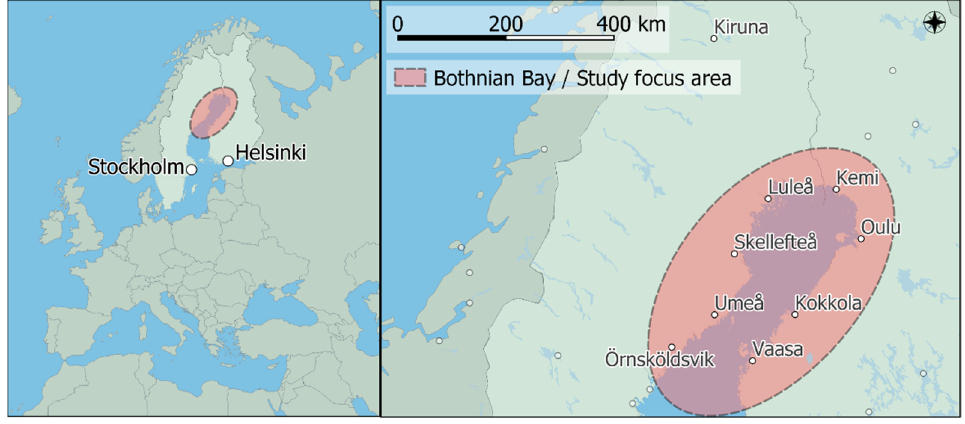
Figure 1. Location of the Bothnia Bay and the study focus area.